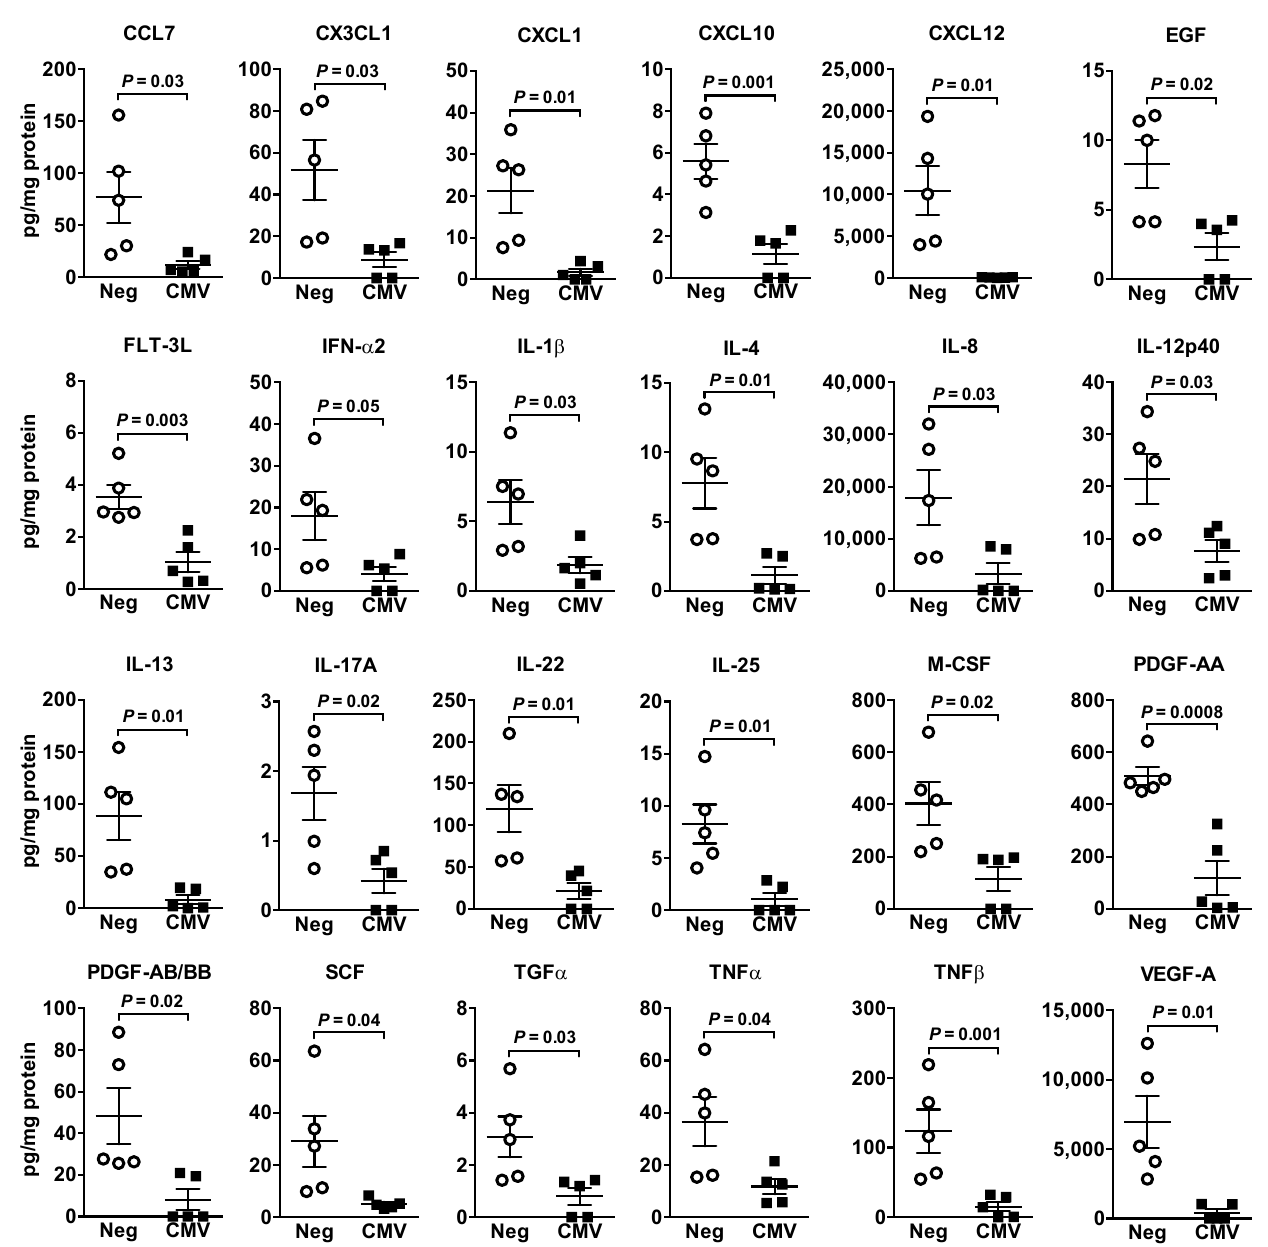
Figure 6. Pro-inflammatory cytokine secretion was decreased after exposing Hs578T breast cancer cells to HCMV. Cells were exposed to 2 MOI HCMV or filtered control (Neg) for 48 h. Concentrations of 71 cytokines/chemokines/growth factors were analyzed in the culture media and those with significant changes are illustrated. Results are means ± SEM from five independent experiments and p -values were calculated by unpaired Student’s t -test. Abbreviations: EGF, epidermal growth factor; FLT-3L, FMS-like tyrosine kinase 3 ligand; IFN, interferon; TGF, transforming growth factor.